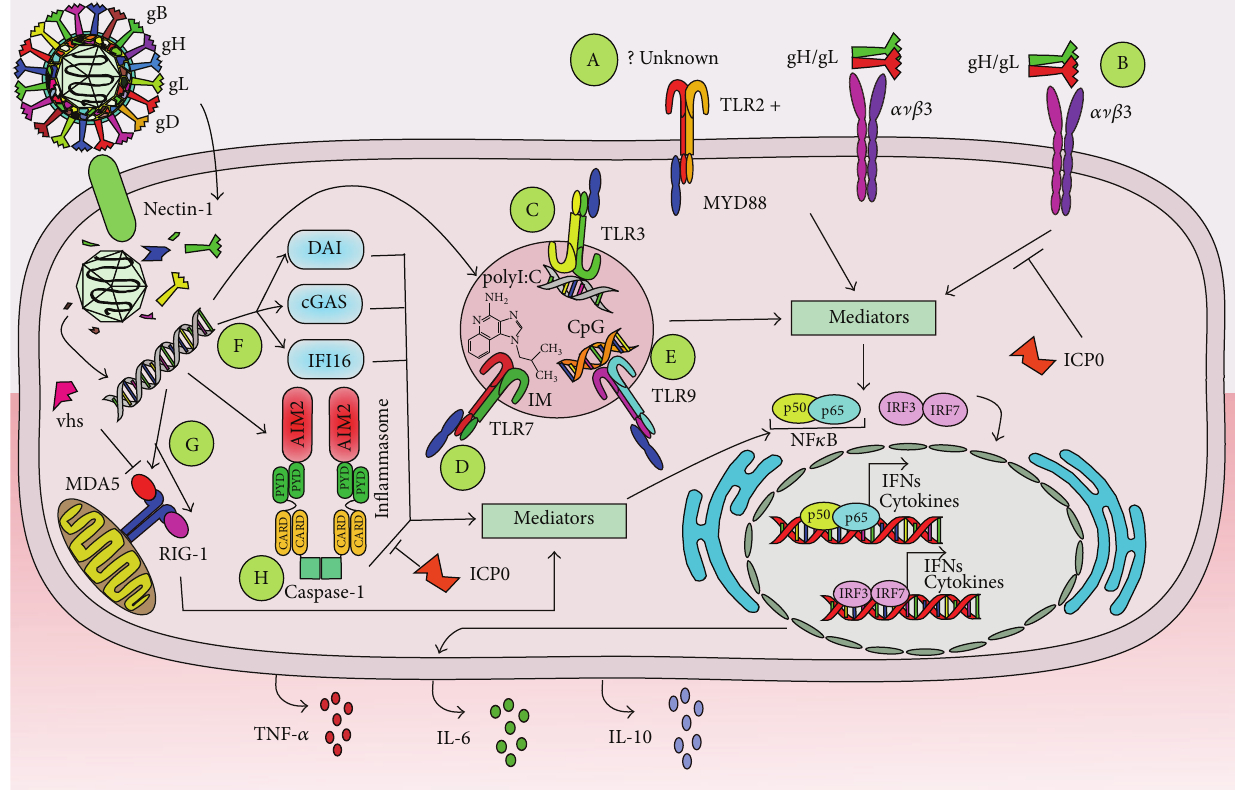
Figure 1: HSVs interfere with host detection of viral determinants. Immune and nonimmune cells express an array of pathogen recognition receptors intended to detect microbes, which ultimately lead to NF- 𝜅 B and IRF translocation into the nucleus and secretion of antiviral molecules, such as interferons and cytokines. A: Host cells can sense HSV determinants through TLR2, although the specific viral elements detected by this receptor are currently unknown. Intracellular signaling through TLR2 can occur with the help of integrin 𝛼 ] 𝛽3 -binding after this receptor binds with the HSV complex gH/gL. B: Alternatively, integrin 𝛼 ] 𝛽3 can signal intracellularly on its own after gH/gL binding. This process can be interfered by ICP0 C: TLR3, D: TLR7, and E: TLR9 engagement by activating ligands, such as polyI:C, imiquimod (IM), and CpG-ODN, respectively, have been shown to play favorable roles against HSV infection by inducing activating pathways within cells that lead to the secretion of antiviral molecules. F: Nucleic acids generated during HSV infection can also be detected by host intracellular sensors, such as DAI, cGAS, and IFI16. G: The RIG-1/MDA5 complex can also detect virus-derived nucleic acids; however its function is blocked by viral vhs. H: Finally, the inflammasome is activated by HSV determinants, although HSV ICP0 can counteract its activity and negatively modulate its